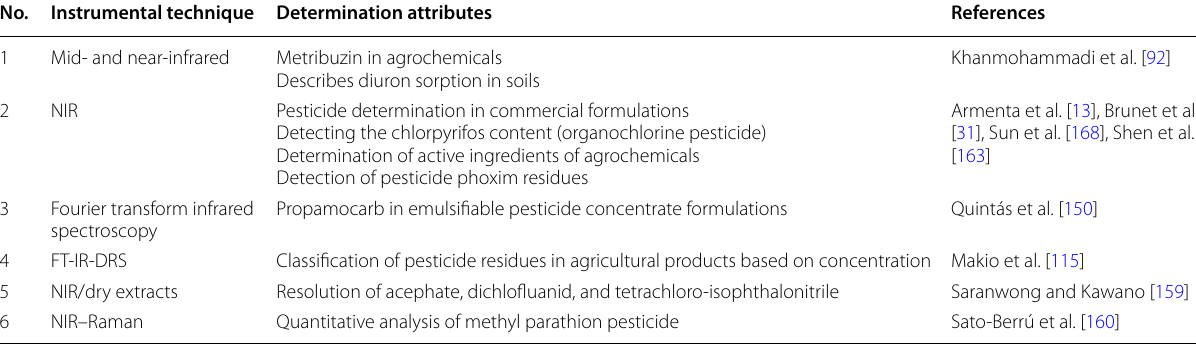
NIR Near-infrared reflectance spectroscopy; and FT-IR-DRS Fourier transform infrared diffuse reflectance spectroscopy